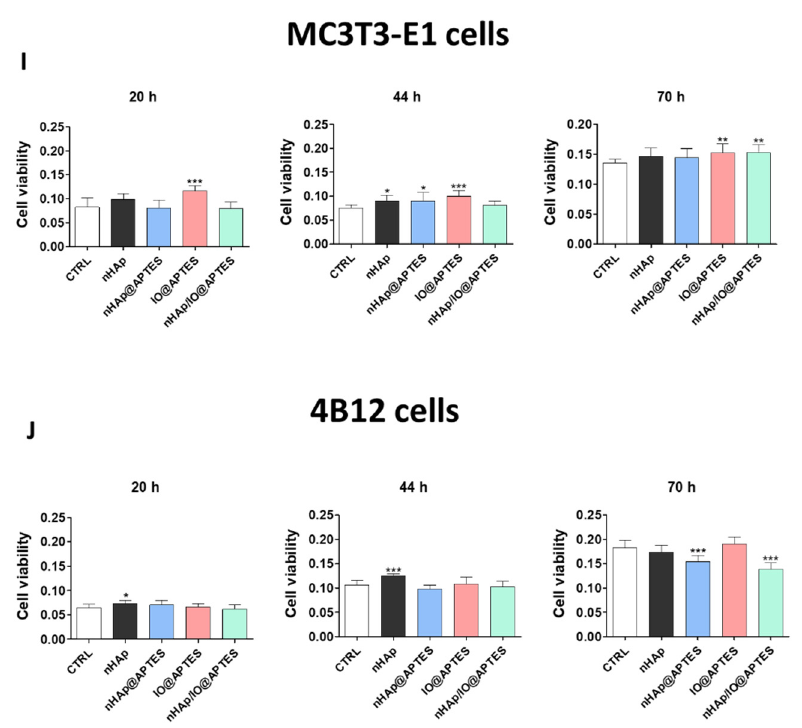
Figure 5. Evaluation of cytotoxicity. The impact of the nHAp ( A ), nHAp@APTES ( B ), IO@APTES ( C ), nHAp/IO@APTES ( D ) on the viability of the MC3T3-E1 cell line after 20, 44 and 70 h incubation and the nHAp ( E ), nHAp@APTES ( F ), IO@APTES ( G ), nHAp/IO@APTES ( H ) on the viability of the 4B12 cell line after 20, 44 and 70h incubation. Merged graphs for MC3T3-E1 ( I ) and 4B12 ( J ). The graphs represents mean values ± standard deviation. Significant differences are indicated as follows (* p < 0.05, ** p <0.01 and *** p < 0.001).